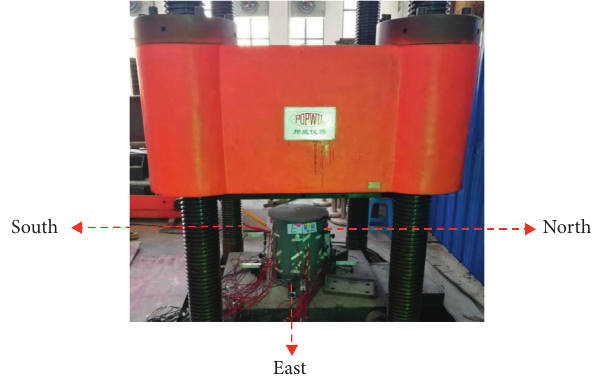
Figure 3: Loading system of the axial compression test.